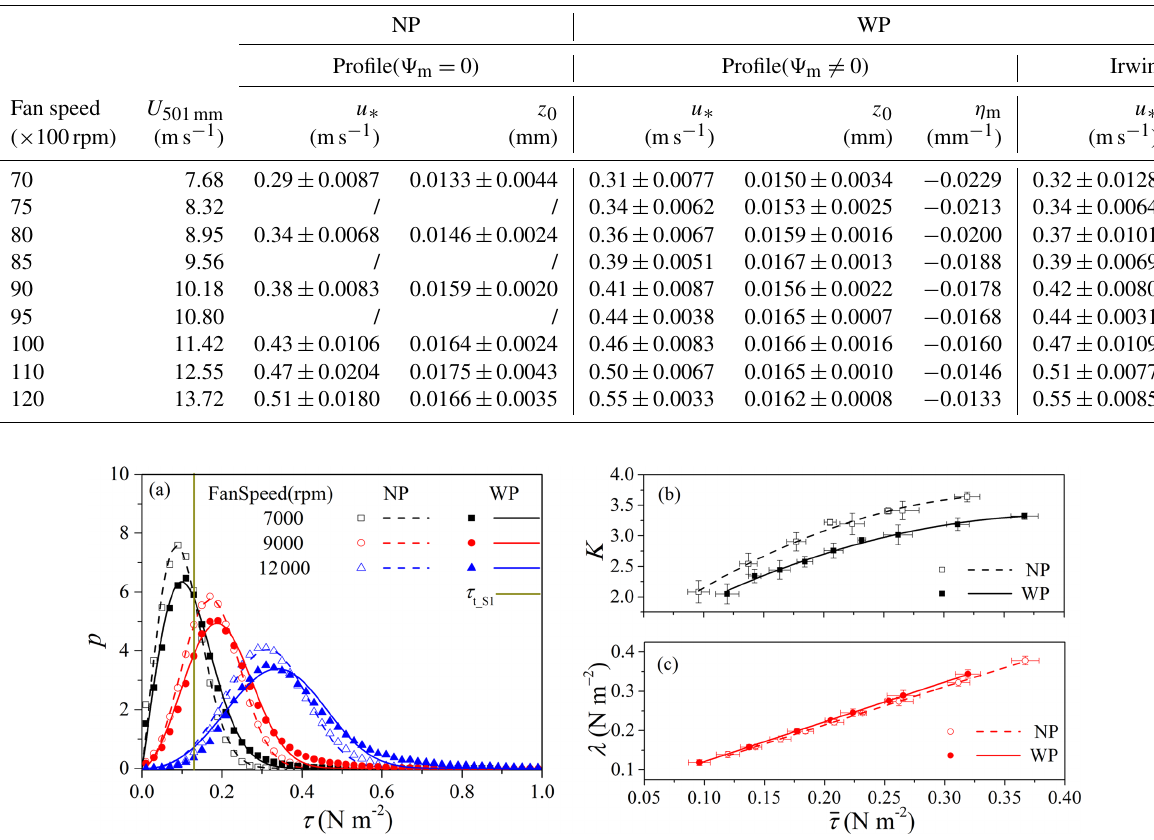
Figure 5. (a) Probability density function of surface shear stress τ for NP and WP runs with a fan speed of 7000, 9000 and 12000rpm. The dashed gray line marks the threshold shear stress for S1 ( τ t_S1 ). The symbols are the results from the Irwin sensors and curves the Weibull distributions. By fitting Eq. (11) to the respective data of the various runs, the corresponding shape parameter K and scaling parameter λ are estimated and plotted against the mean shear stress τ in (b) and (c) , respectively. The curves are polynomial fits. In (b) , the solid black line shows K = − 15 . 10 τ 2 + 12 . 28 τ + 0 . 85 and the dashed black line K = − 21 . 15 τ 2 + 15 . 65 τ + 0 . 79. In (c) , the solid red line shows λ = 1 . 01 τ + 0 . 02 and the dashed red line λ = 0 . 97 τ + 0 .